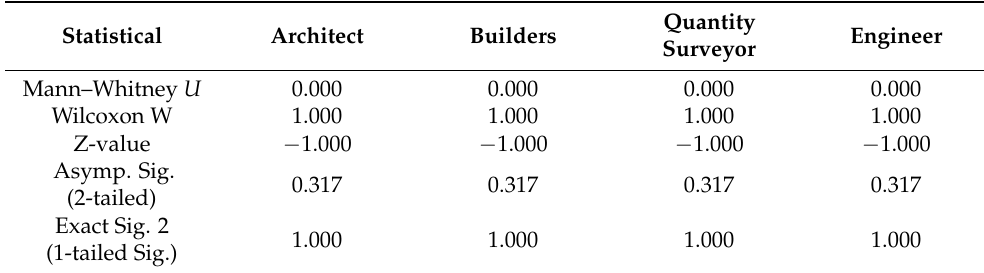
Table 5. Mann–Whitney U Test Statistical Parameters on Rating of Industrial Application Drivers of